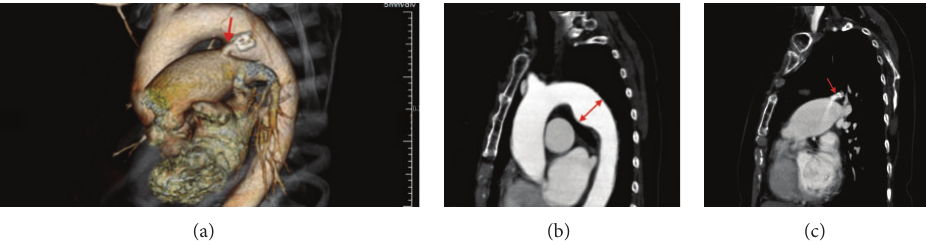
Figure 1: (a) A volume rendering CT image showing the PDA (red arrow). (b) A curved planar CT reformation image showing the TAA (red arrow; diameter, 41mm). (c) A curved planar CT reformation image showing the PDA (red arrow; diameter, 6mm) with contrast enhancement and calcification.